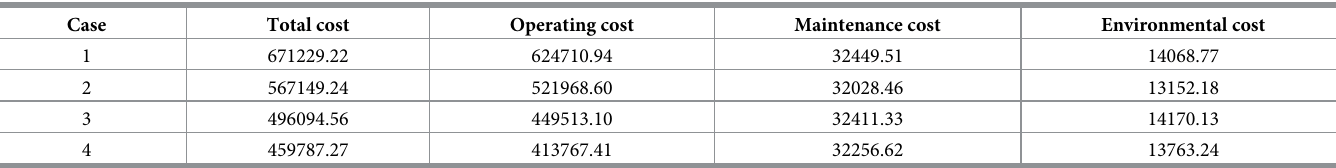
Table 2. Cost of the objective function in Cases 1–4